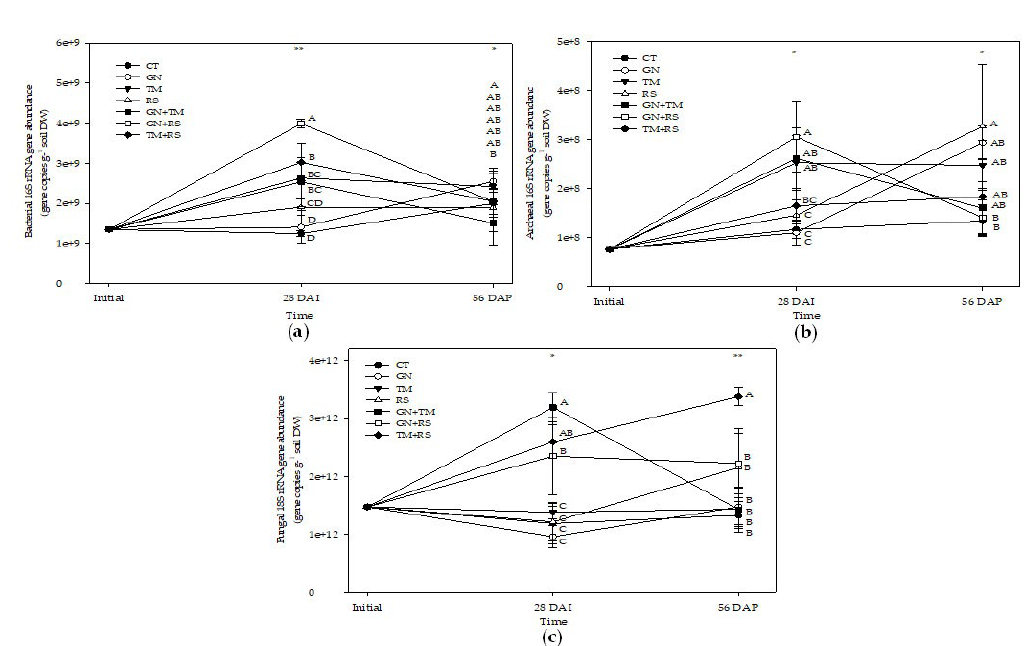
Fig. 1. Bacterial (a), archaeal (b), and fugal (c) abundance in soil treated with different quality organic (CT: untreated control, GN: groundnut, TM: tamarind, RS: rice straw, GN+TM: groundnut + tamarind, GN+RS: groundnut + rice straw, TM+RS: tamarind + rice straw). *, ** significantly different at p < 0.05, and 0.01,